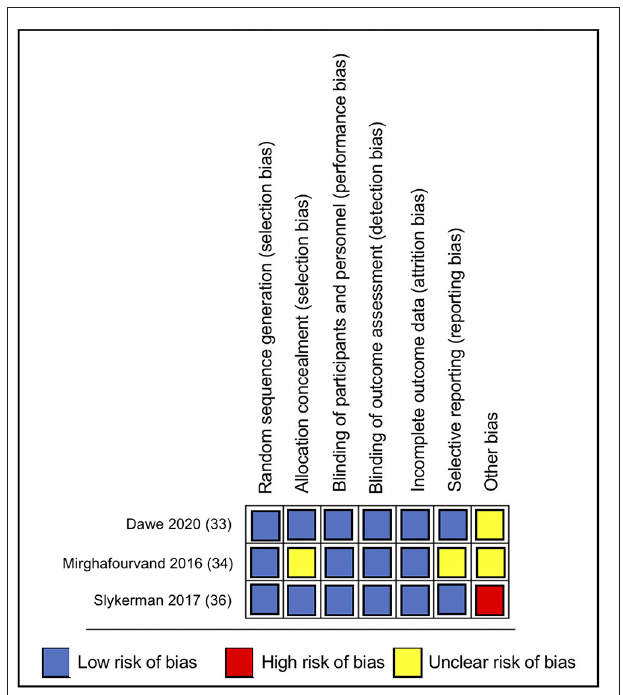
FIGURE 3 | Risk of bias